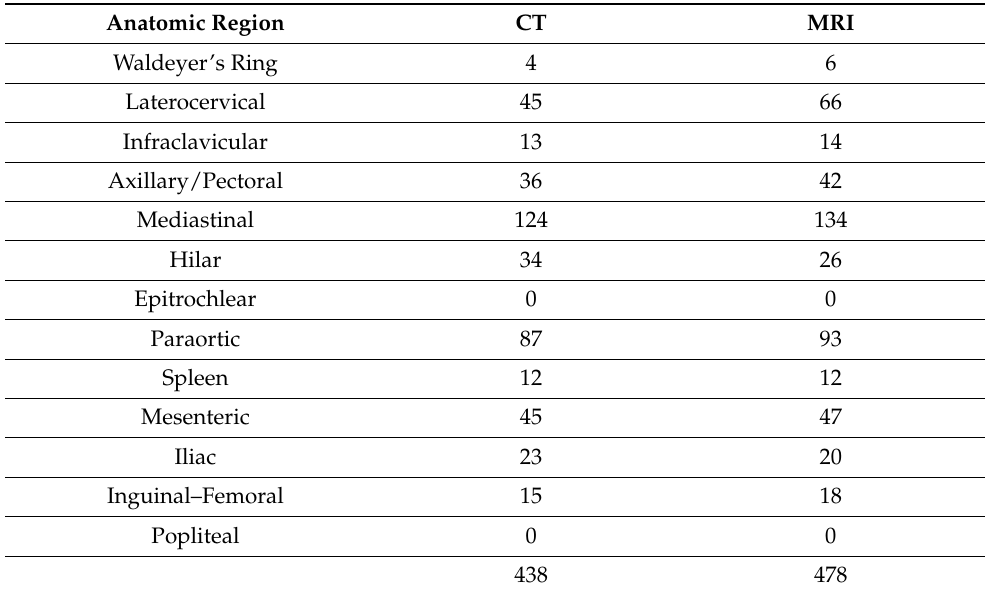
Table 1. Pathological lymph nodes detected by CT, and MRI classified by anatomic